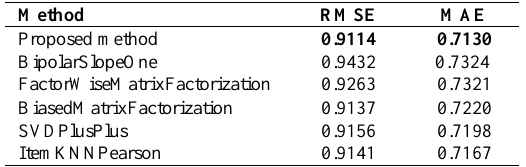
Table 2. The Proposed approach compared with the basic algorithms.